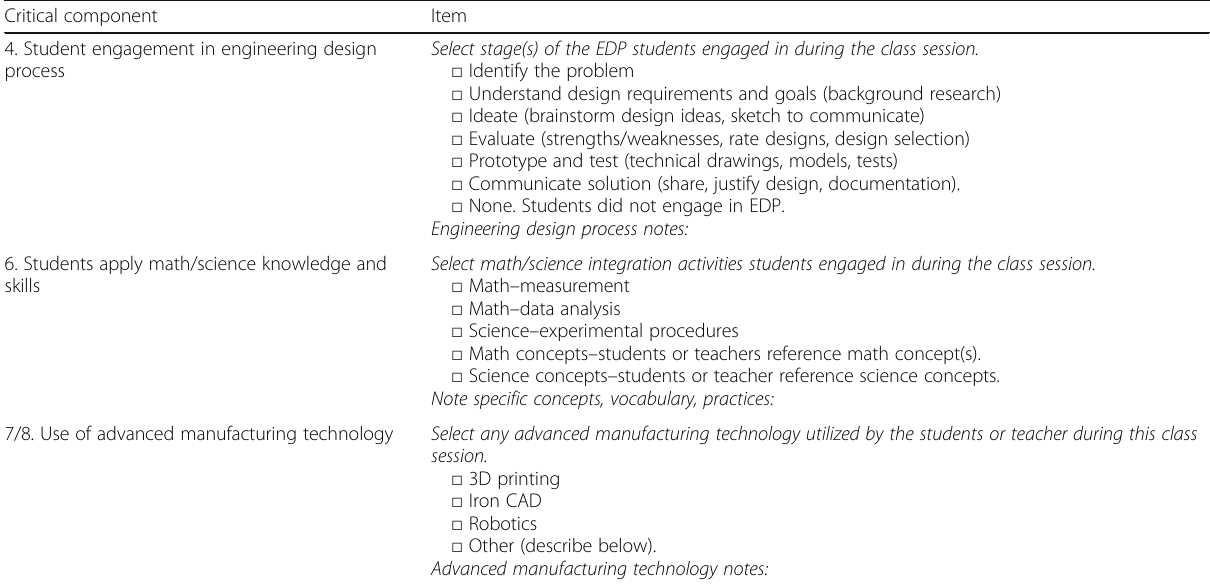
Table 3 Example items from STEM-ID observation protocol Critical component